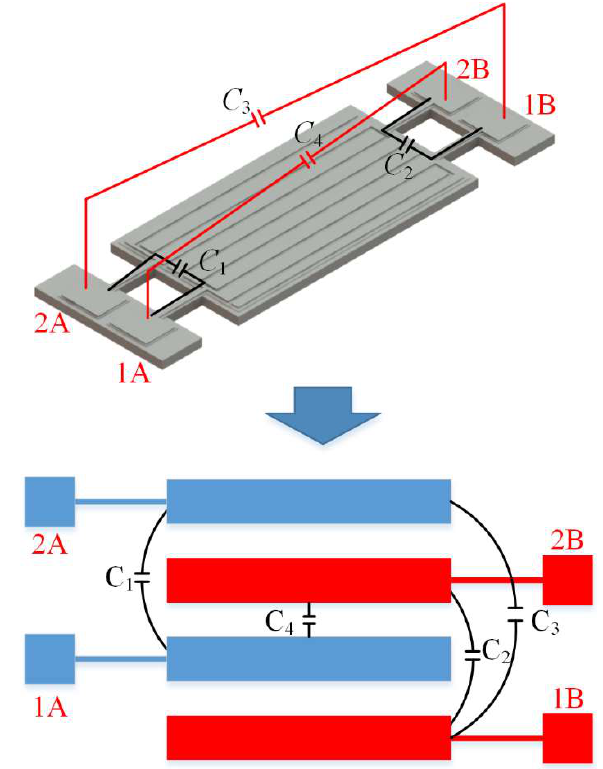
Figure 9. Schematic of the parasitic capacitive feedthrough in the proposed resonator. These ports are divided into two sets. The electrodes in the same set connected to input and output ports respectively are located on the regions with same strain polarity. The polarity of electrodes of these two sets of ports are inverse. C 1 and C 2 are the direct feedthrough between the input and output ports within one set. C 3 and C 4 are the cross feedthrough between the input and output ports belonging to different sets.